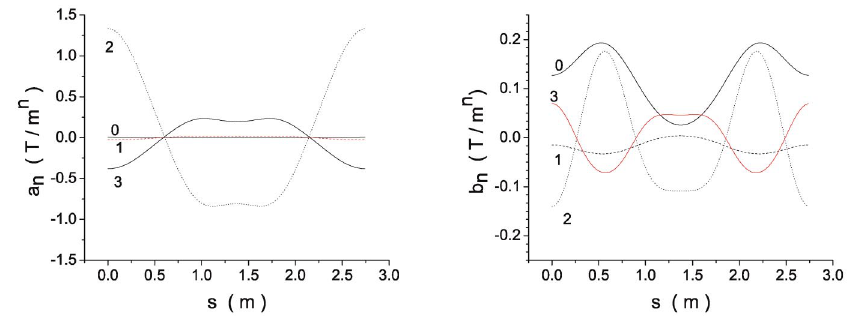
FIG. 4. (Color) On-axis normal (left) and skew (right) multipoles for one cell of the RFOFO ring. The curves are labeled with the multipole order, 0 for dipole, 1 for quadrupole,